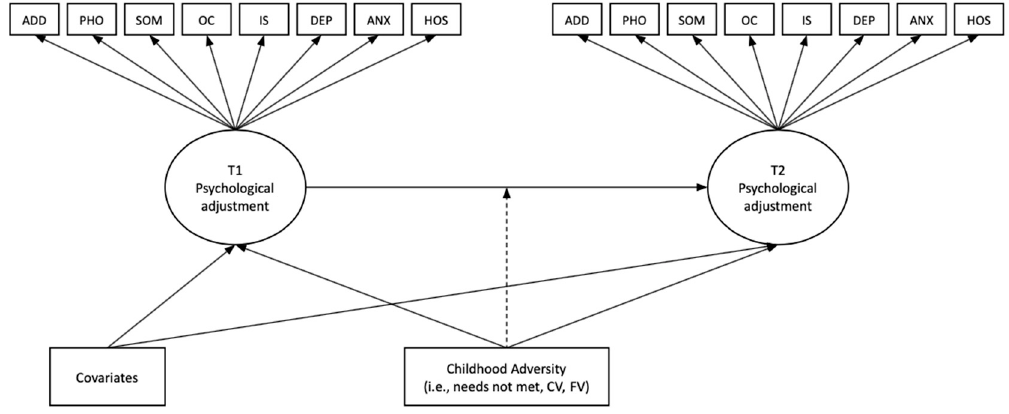
Figure 1. Analytic Model.